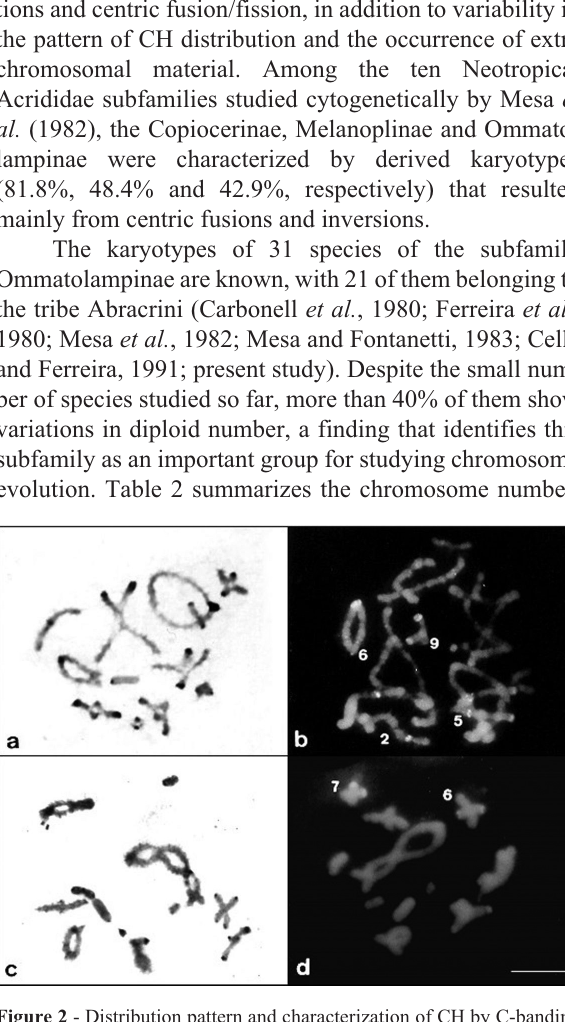
Figure 3 - Nucleolar organizer regions detected by silver nitrate staining (arrows) and fluorescent in situ hybridization (FISH) in meiotic cells of O. rufipes (a,b) and E. fusiformis (c,d). Bar = 5 (cid:2)